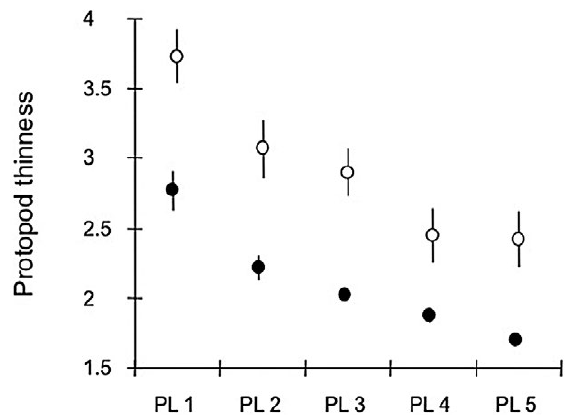
Fig. 3. – Mean pleopod (PL) protopod thinness index (length/width) (±standard error of the mean) of female (white circles) and male (black circles) Pasiphaea sivado .